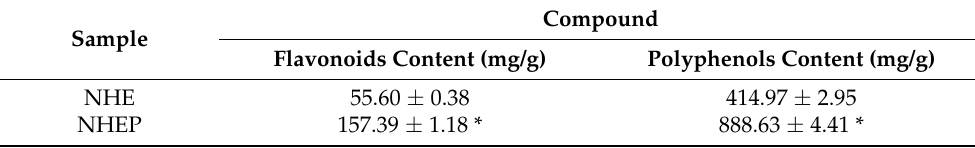
The data shows as the mean ± S.D. ( n = 3). *: p < 0.05 compared to